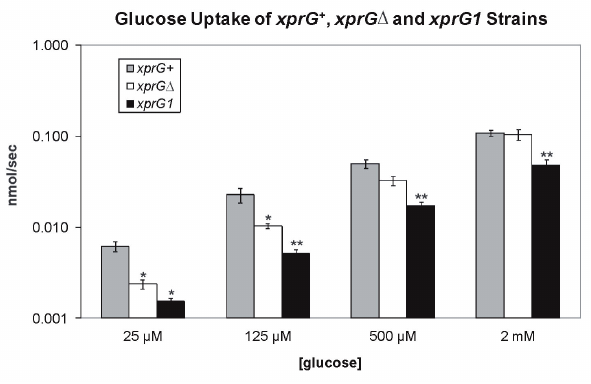
Figure 6. Glucose uptake, in 2.5 x 10 7 germinating conidia, in the first 60 s after transfer to 25 µM, 125 µM, 500 µM or 2 mM glucose. The results are the average for four ( xprG D 1, xprG1 ) and five ( xprG + ) experiments and standard errors are shown. The rate of glucose uptake was compared with the uptake of the xprG + strain at each concentration of glucose using an unpaired t-test. Values which differed significantly from the value for the xprG + strain are indicated with asterisks (*p < 0.5, **p < 0.1) The full genotypes of the xprG + (MH2), xprG D (MK422) and xprG1 (MK85) strains are given in Table